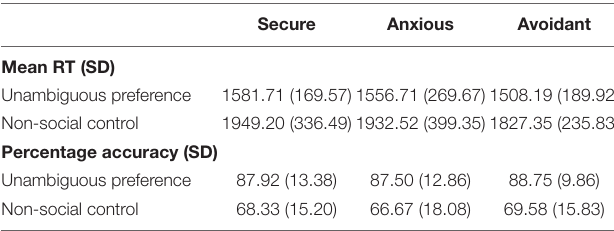
TABLE 2 | Means and standard deviations for percentage accuracy and reaction time (RT) data for the preference condition (unambiguous preference and non-social control), presented by Condition and